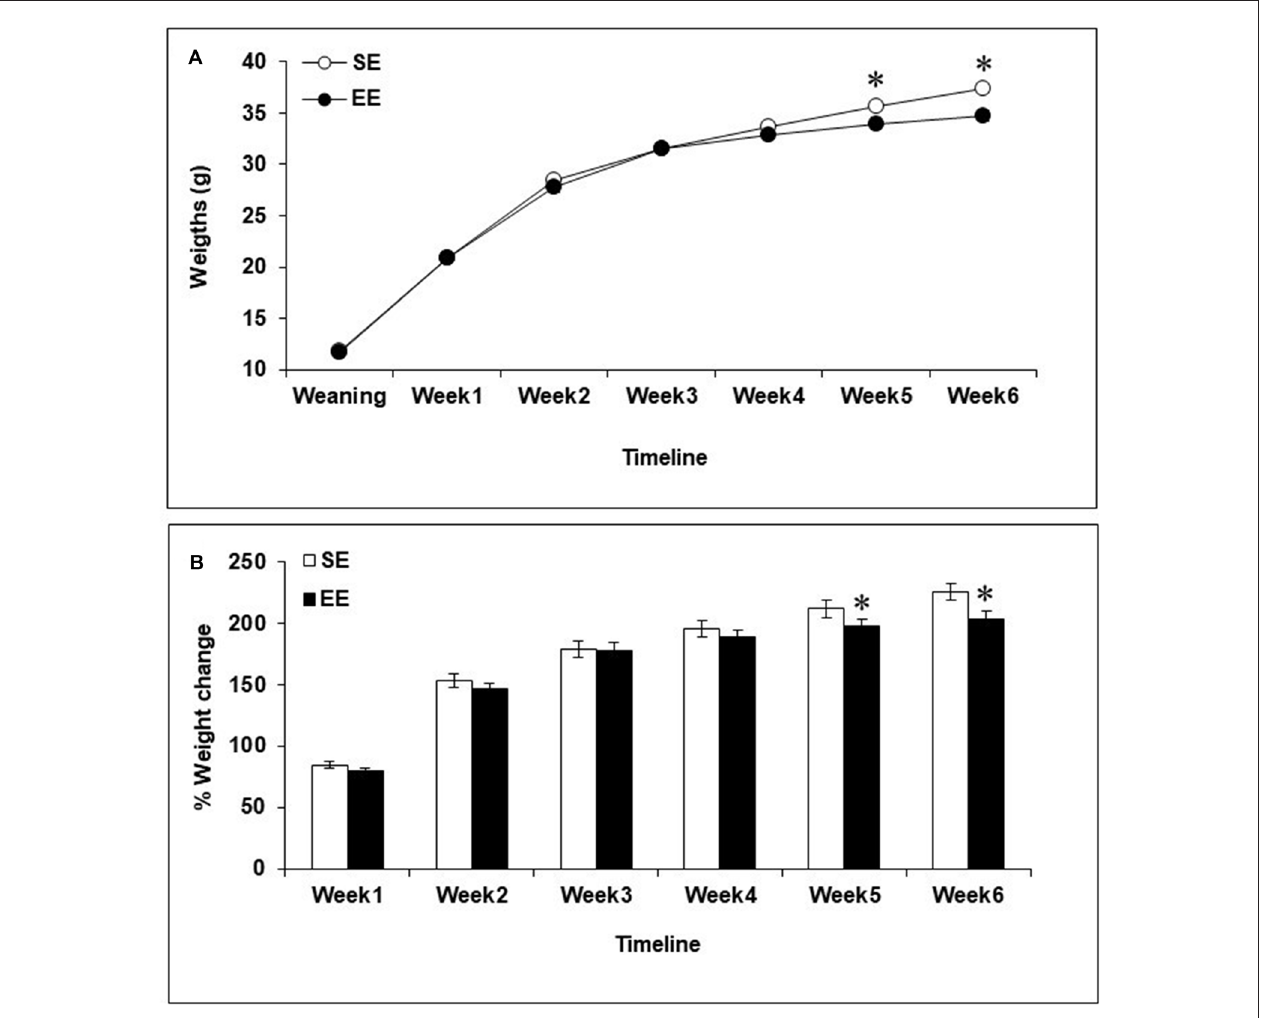
FIGURE 1 | Body weights among mice housed in a standard environment (SE) or an enriched environment (EE) during 6 weeks. (A) Actual weights increased over the course of the 6-week housing in both SE and EE mice, but EE mice weighed less than SE mice during Weeks 5 and 6. (B) Mice housed in EE gained as much weight as mice housed in SE at Weeks 1–4 but at Weeks 5 and 6, percentages of weight change from weaning were reduced in EE mice compared to SE mice. ∗ p < 0.05 relative to mice housed in SE. Data represents means ± SEM (mice housed in SE, n = 33; mice housed in EE: n = 36).